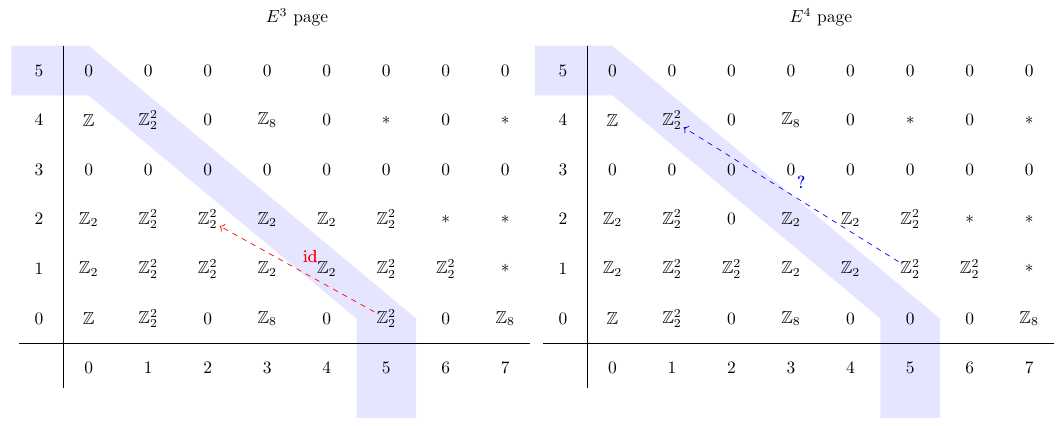
Figure 9. Another possibility for the elimination of the entry E 1 , 4